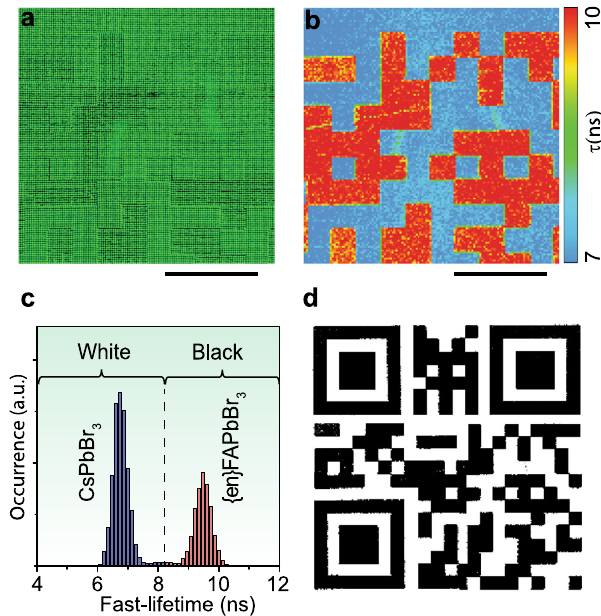
Fig. 5 FLI microscopy (FLIM) imaging and binarization of FLQR tags. a Zoomed-in view of the central portion of the unicolour FLQR code printed with CsPbBr 3 and {en}FAPbBr 3 inks. b TCSPC-FLI microscopy pseudo- colour image of the same region (scale bars are 400 µ m). c The two inks exhibit two distinct fast-lifetime (see Supplementary Note 6) histograms that can be de fi ned as white (lifetime ~6.5 ns, blue) and black (lifetime ~9.5 ns, red) to create a machine-readable QR code d (pattern size is identical to that in Fig. 4a). Please try to scan it with your smartphone.